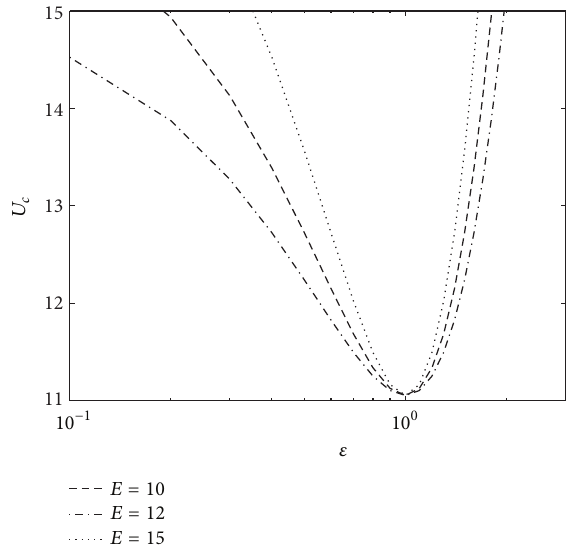
Figure 5: The neutral curves of velocity ratio versus ratio of dielectric constants of two fluids for the different values of electric field intensity when 𝑊 = 100 , 𝜇 = 0.018 , 𝜌 = 0.0012